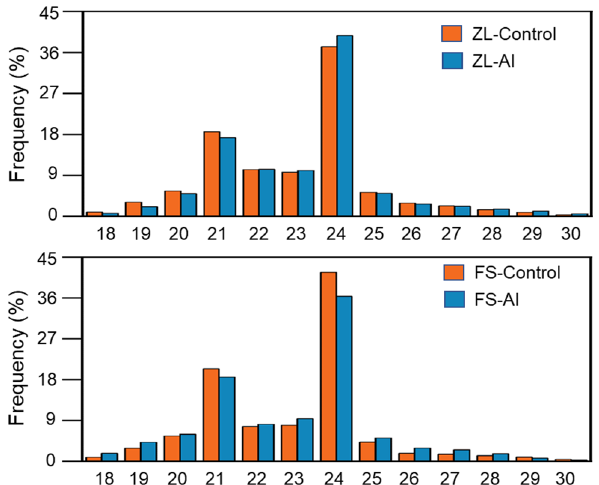
Figure 1. Length distribution of small RNAs in roots of ZL and FS. The X-axis represents the small RNA length (nucleotide) and the Y-axis represents the percentage of small RNA reads. Control corresponds to hydroponically grown in basic nutrition solution and Al represents 50 µM Al treatment for 24 h.